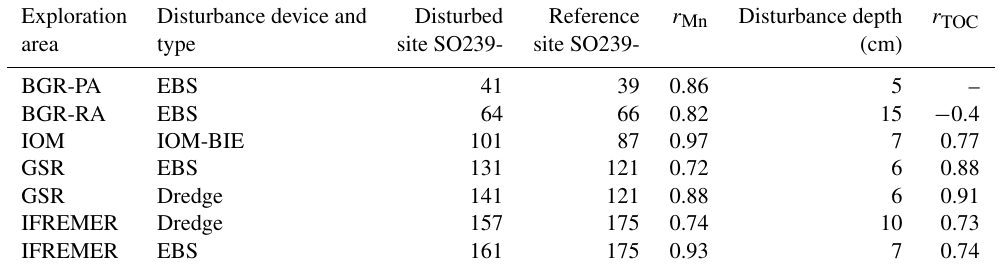
Table 3. Calculated Pearson correlation coefficients r Mn and r TOC for the determination of the disturbance depth of various small-scale dis- turbances investigated in the framework of this study (compare Table 1). For both correlations, the highest positive linear Pearson coefficient for solid-phase Mn contents ( r Mn ∼ 1) between the disturbed sites and the respective undisturbed reference sites was used.